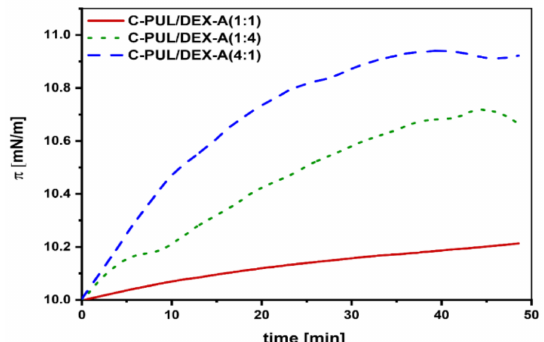
Figure 7. Changes in the surface pressure with time after spreading of 50 µ L of a nanogel systems C-PUL / DEX-A at the di ff erent ratio on a EYPC monolayer compressed to 10 mN / m.